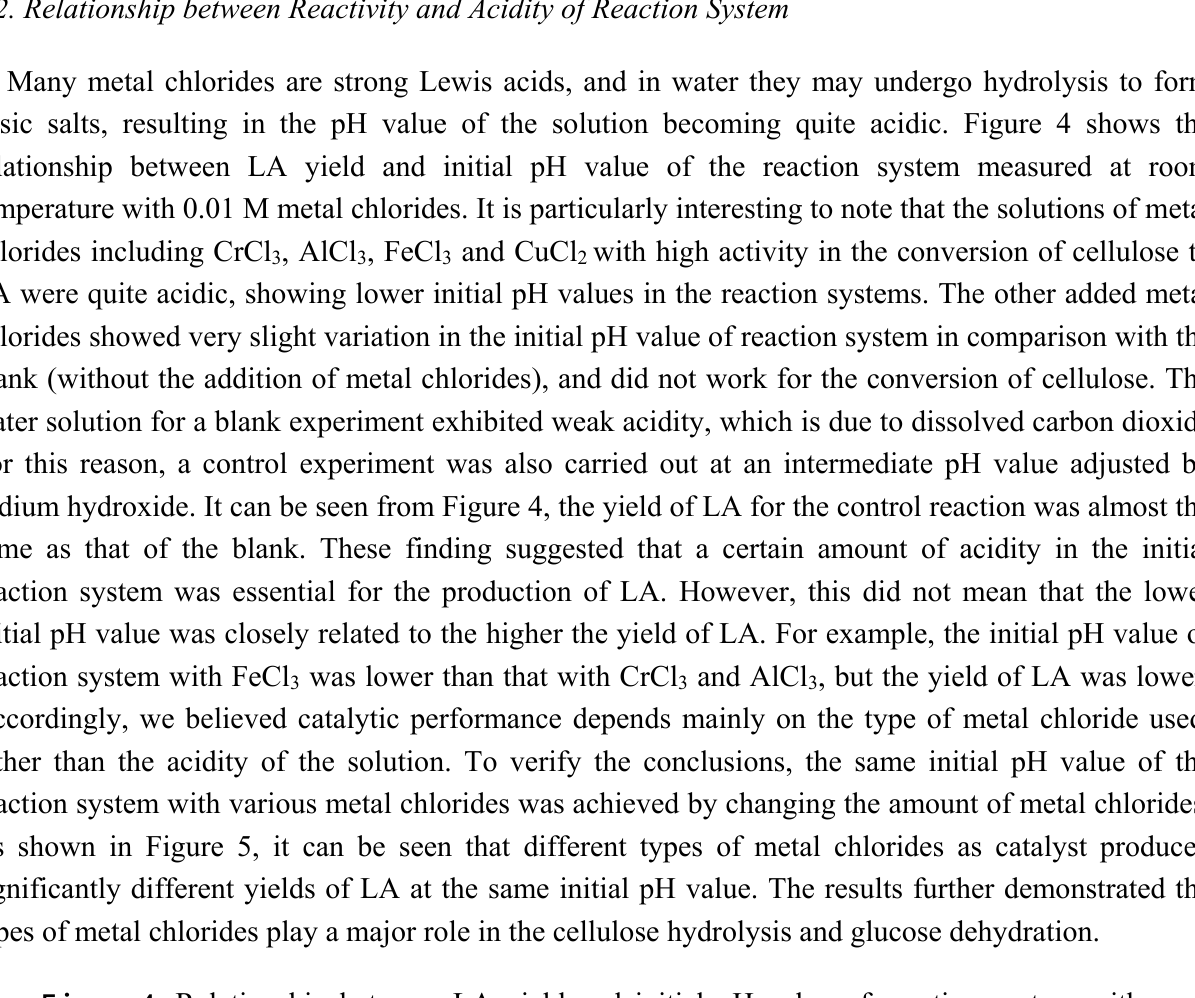
Figure 4. Relationship between LA yield and initial pH value of reaction system with 0.01 M metal chlorides measured at room